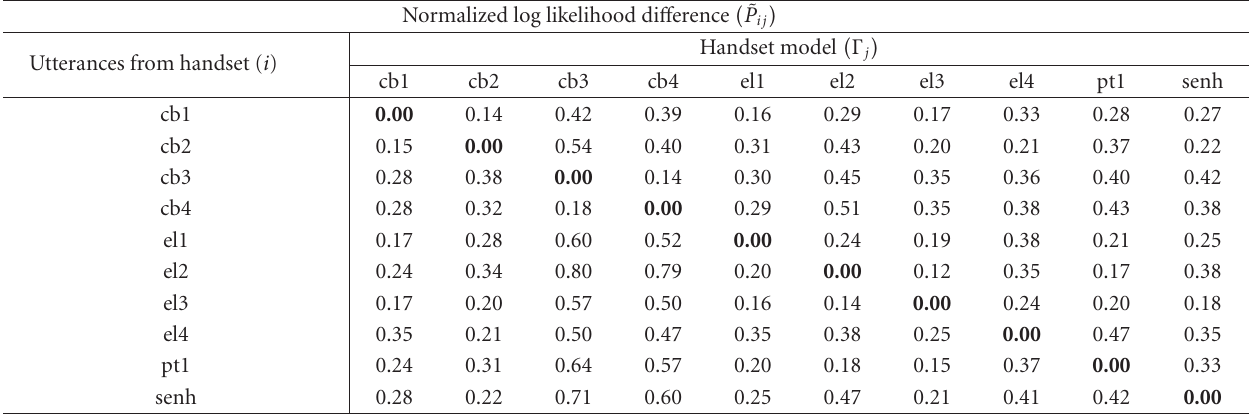
Table 1: Normalized log likelihood di ff erences of ten handsets (see (15)). Entries with small (large) value mean that the corresponding handsets are similar (di ff